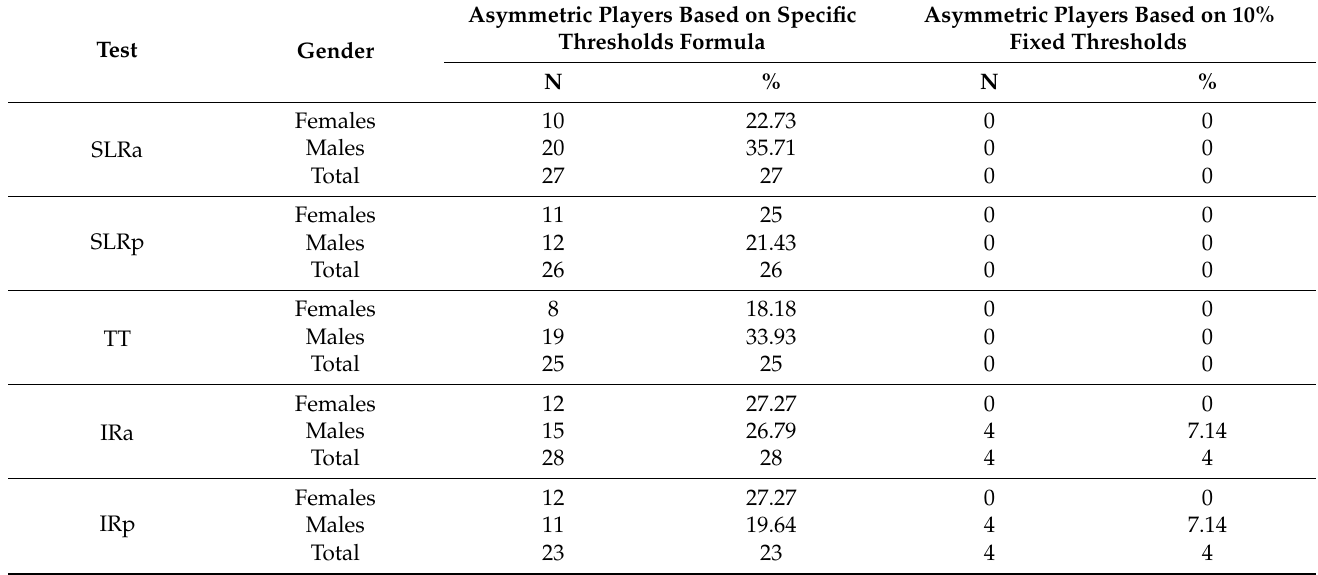
Table 2. Individualized magnitude of asymmetry analysis of the players for each ROM test. Asymmetric Players Based on Test Gender